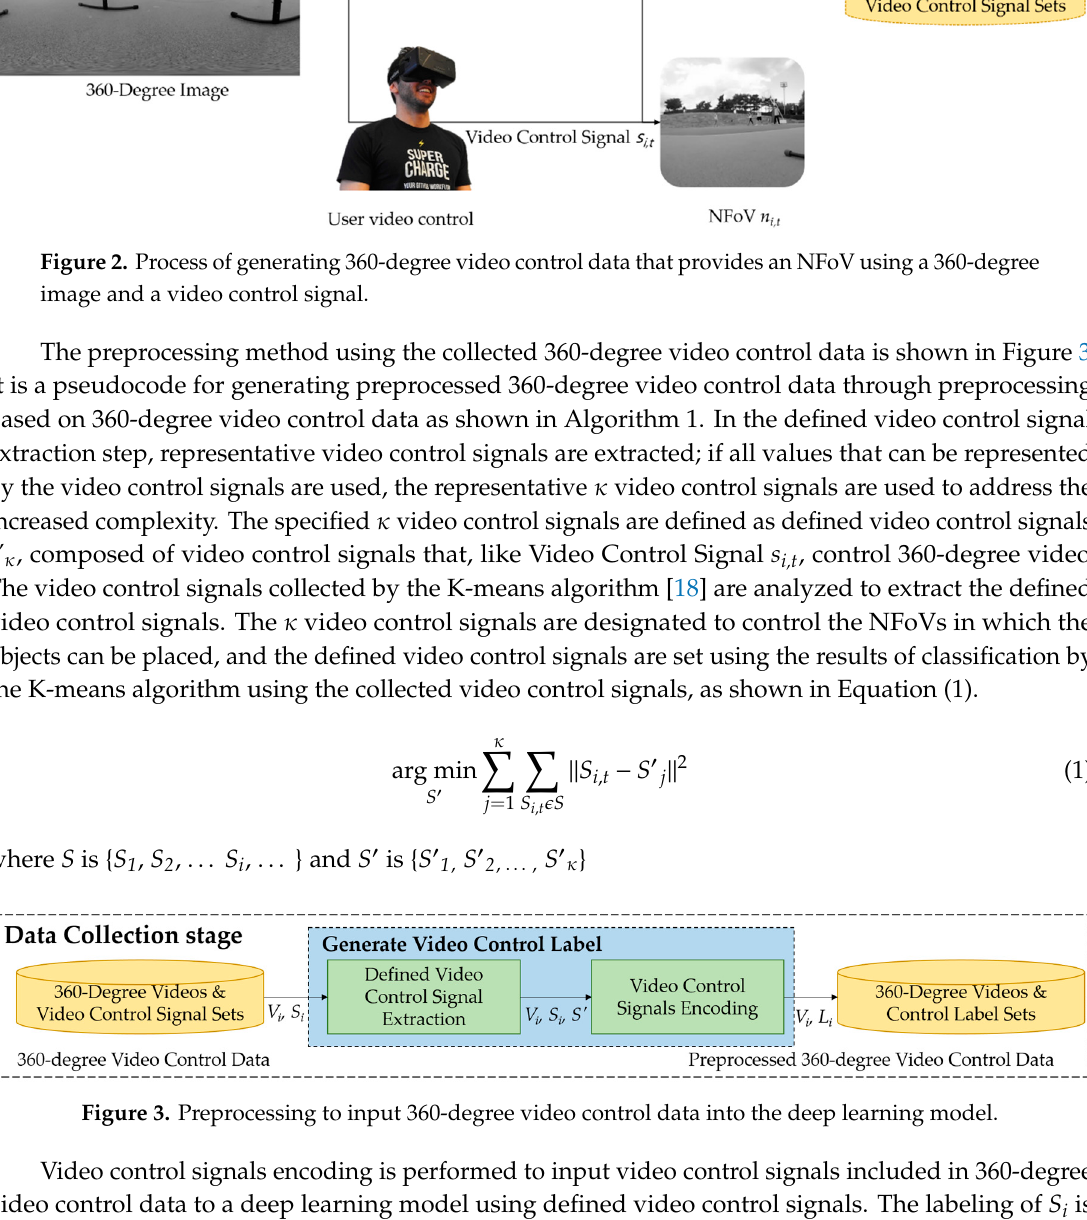
Algorithm 1 Pseudocode for generating preprocessed 360-degree video control data using 360- degree video and 360-degree video control signals.